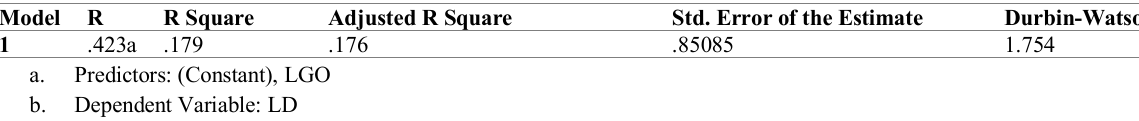
Table 4: Model Summary for Regression of LD against LGO